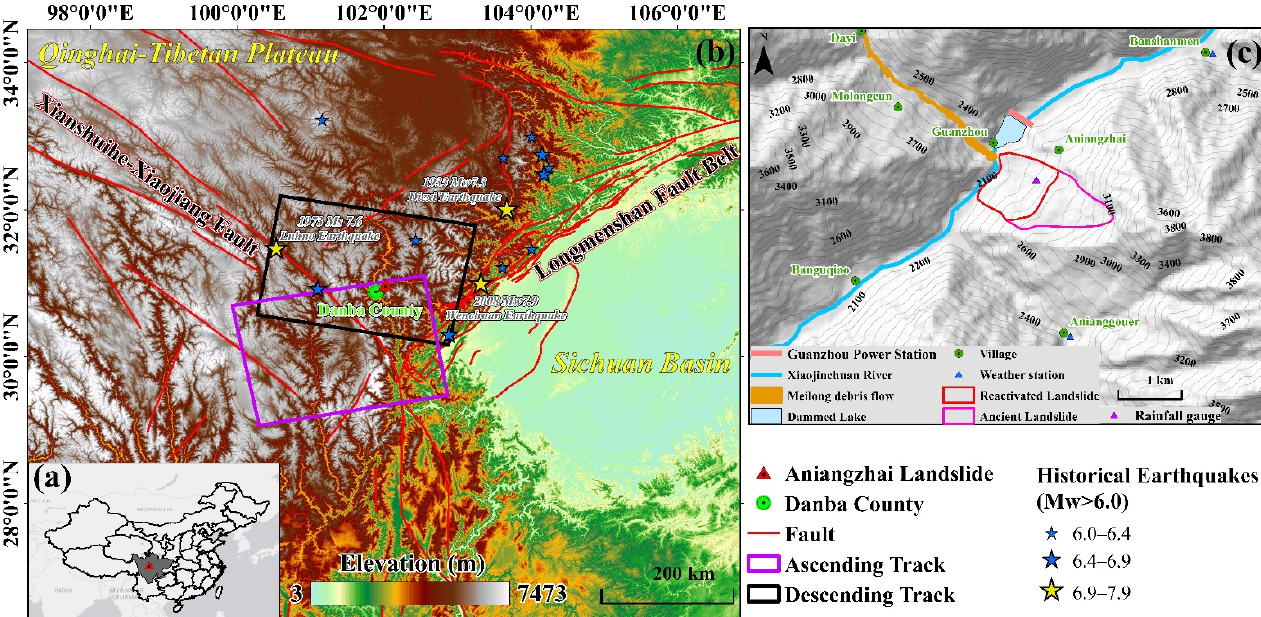
Figure 1. Geological setting of the study area: ( a ) overall location of the study area; ( b ) regional tectonic setting and topography map derived from the 1-arc-second Digital Elevation Model (DEM) of the Shuttle Radar Topography Mission (SRTM) [46]; ( c ) overview of the multi-hazard chain in the study area. Black lines indicate the contour lines.